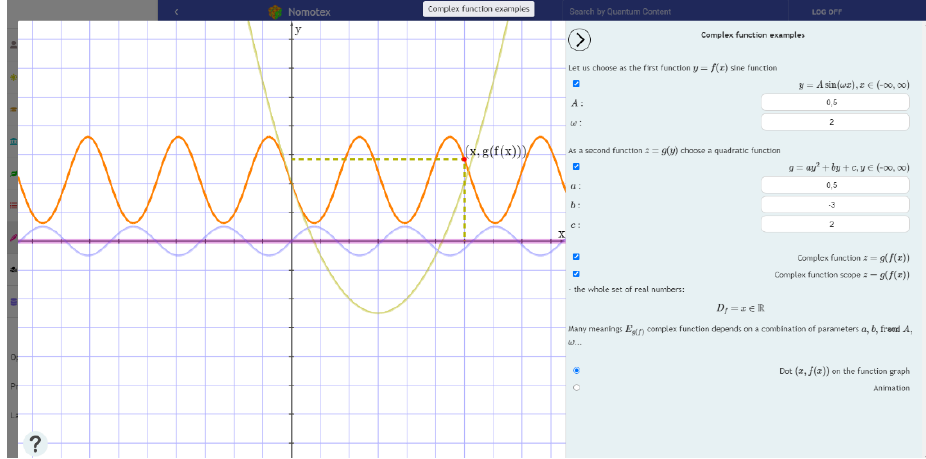
Fig. 2. Window of the subsystem «Visual mathematics» in the Nomotex DLS. Course «Mathematical analysis», Mathematical example «complex